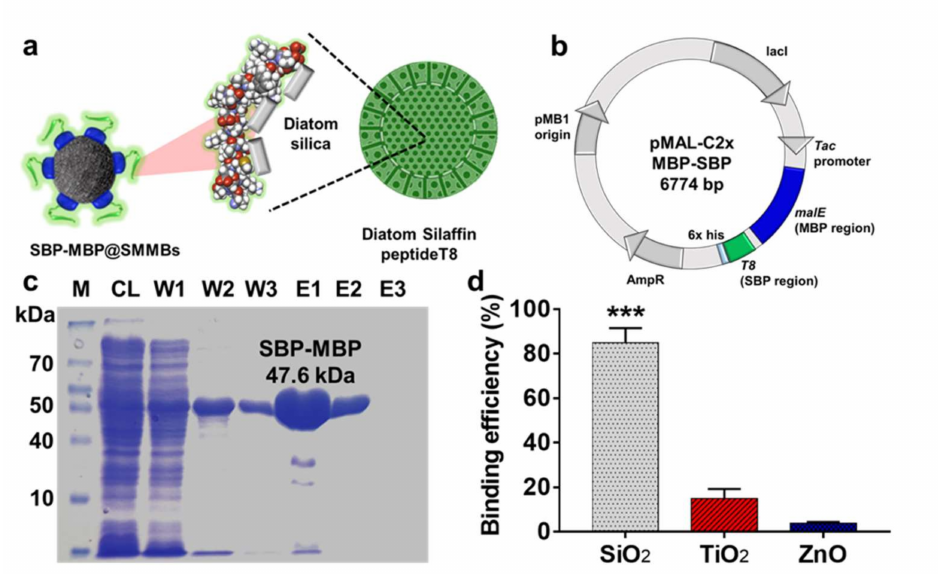
Figure 1. ( a ) Schematic illustration showing the starch magnetic microbeads functionalized with silica binding peptide (SBP-MBP@SMMBs). The SBP was designed based on the T8 domain of silaffin, which exhibits a specific affinity to silica and is associated with the formation of the diatom’s biosilica. ( b ) The map of expression vector, pMAL-C2x, harboring malE and T8 genes, encoding the MBP and SBP in fused form. ( c ) SDS-PAGE analysis of purified MBP-SBP. M, standard size maker; CL, cell lysate; W, washing fraction; E, elution fraction. ( d ) Specific binding efficiency of MBP-SBP for commercial food additive SiO 2 over other types of inorganic food additive TiO 2 and ZnO particles. The asterisks (***) indicate significant difference at p < 0.001 for the specific affinity of MBP-SBP for SiO 2 over the non-target group, TiO 2 , and ZnO. The error bars represent the standard deviation (n =